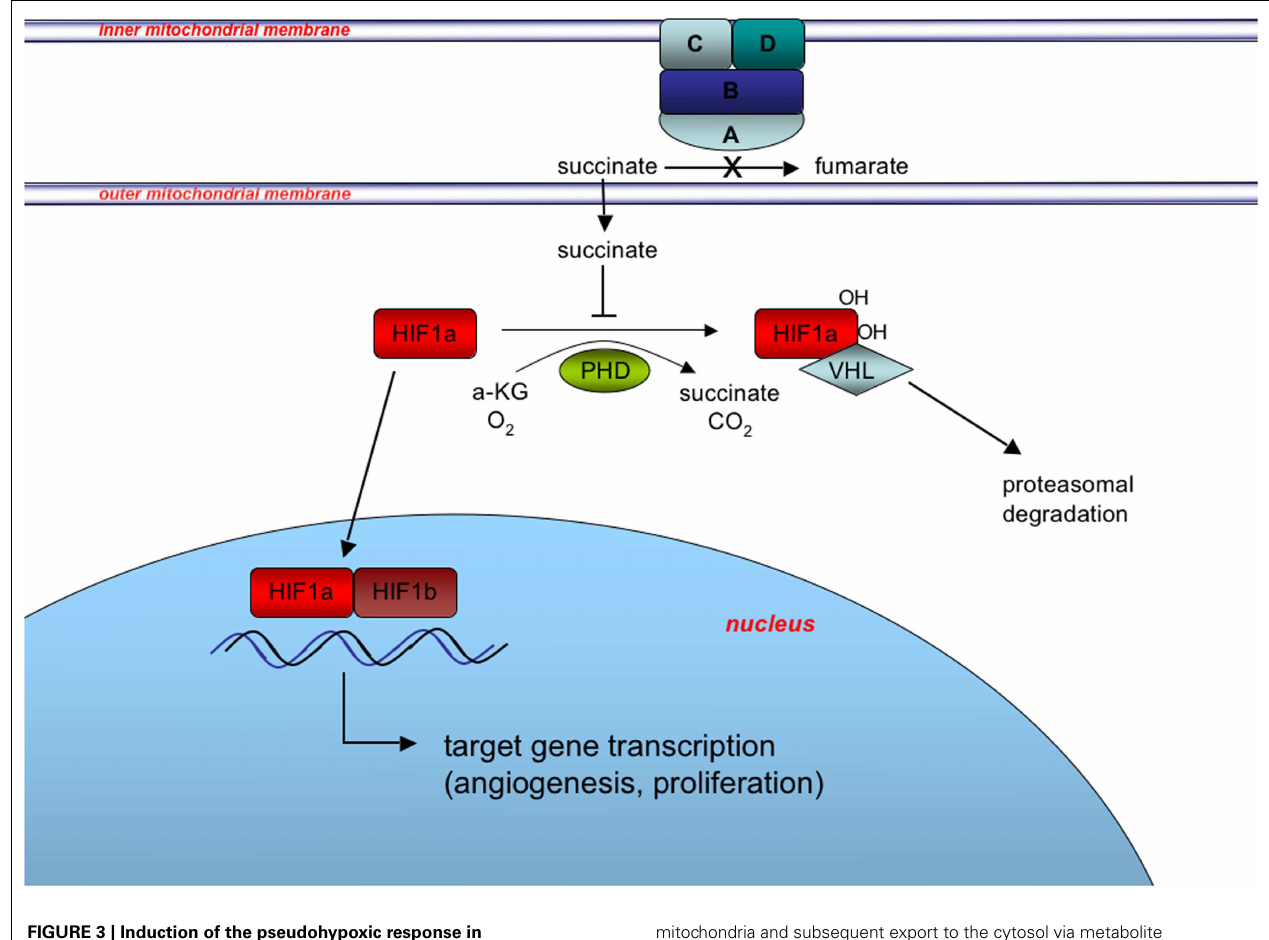
FIGURE 3 | Induction of the pseudohypoxic response in SDH-deficient GIST . SDH, composed of the catalytic subunit (SDHA and SDHB) anchored to the inner mitochondrial membrane through subunits SDHC and SDHD, oxidizes succinate to fumarate as part of the tricarboxylic acid (TCA) cycle and couples this oxidation to the reduction of Coenzyme Q (CoQ, ubiquinone) as complex II of the electron transport chain (not shown). Inactivation of SDH via SDHX gene mutation or other mechanisms leads to succinate accumulation in the